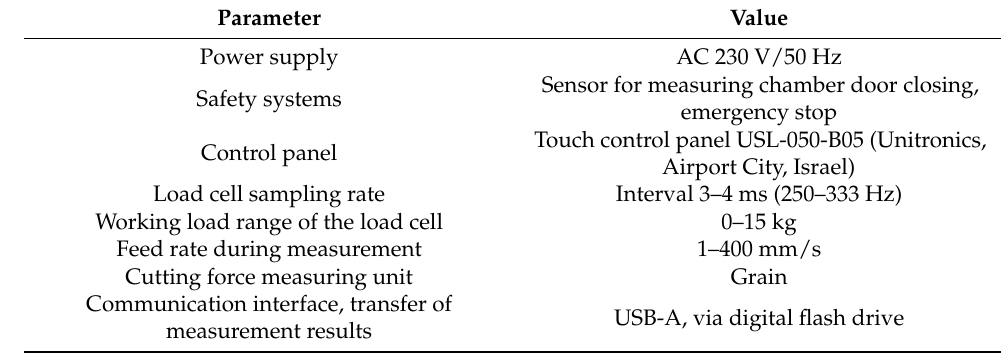
Table 1. Technical parameters of the cutting force measurement